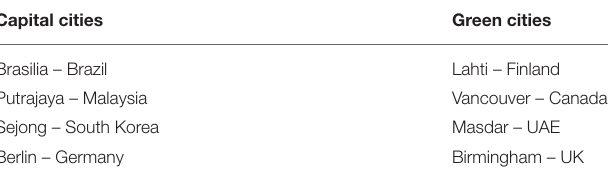
TABLE 1 | Selected cities for researching character of capital green